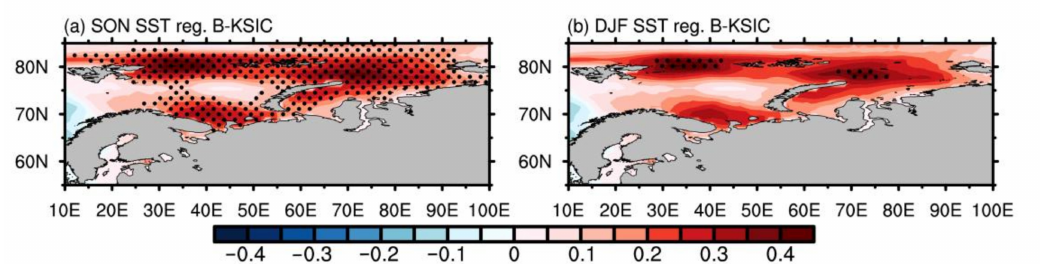
Figure 11. Linear regression of ( a ) autumn SST anomaly (shaded, unit: ◦ C) and ( b ) winter SST anomaly (unit: ◦ C) on autumn B-KSIC during 1979–2015. The dotted region indicates significance at the 95% level from the t test.